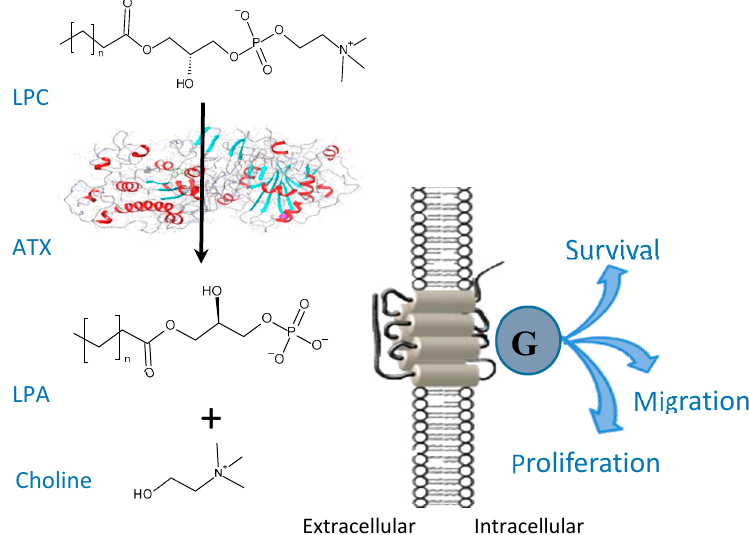
Figure 1. Lysophosphatidylcholine (LPC) is hydrolyzed by autotaxin (ATX) to lysophosphatidic acid (LPA); role of LPA on downstream signaling in cells.